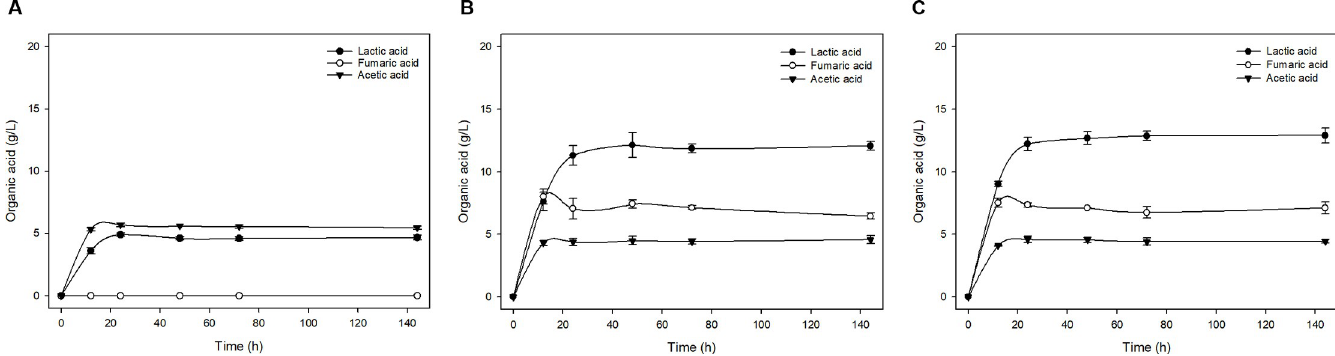
Fig 5. Simultaneous saccharification and fermentation (SSF) processes. Time courses of organic acid production for the kimchi cabbage waste (KCW) of 3.0% (dry matter, w/v). (A) W . cibaria WiKim28. (B) L . sakei WiKim31. (C) L . curvatus WiKim38.